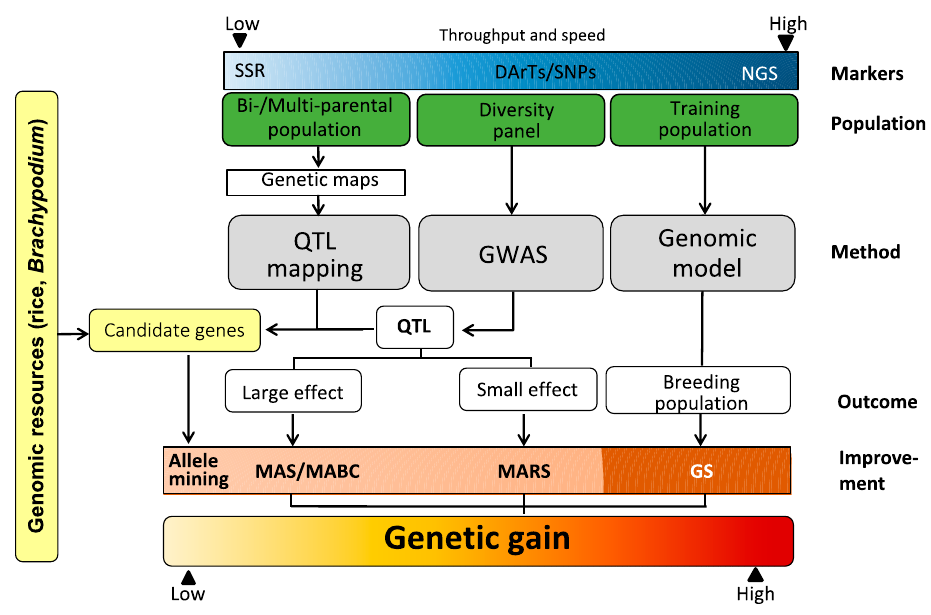
Figure 1. Techniques for genomics-assisted breeding (based on an idea of Bohra et al. [15], adapted). Figure SSR = Single sequence repeat, DArT = Diversity Array technique, SNP = Single nucleotide polymorphism, NGS = Next-generation sequencing, QTL = quantitative trait locus, GWAS = genome- wide association studies, MAS = Marker-assisted selection, MABC = Marker-assisted backcrossing, MARS = Marker-assisted recurrent selection, GS = Genomic selection.